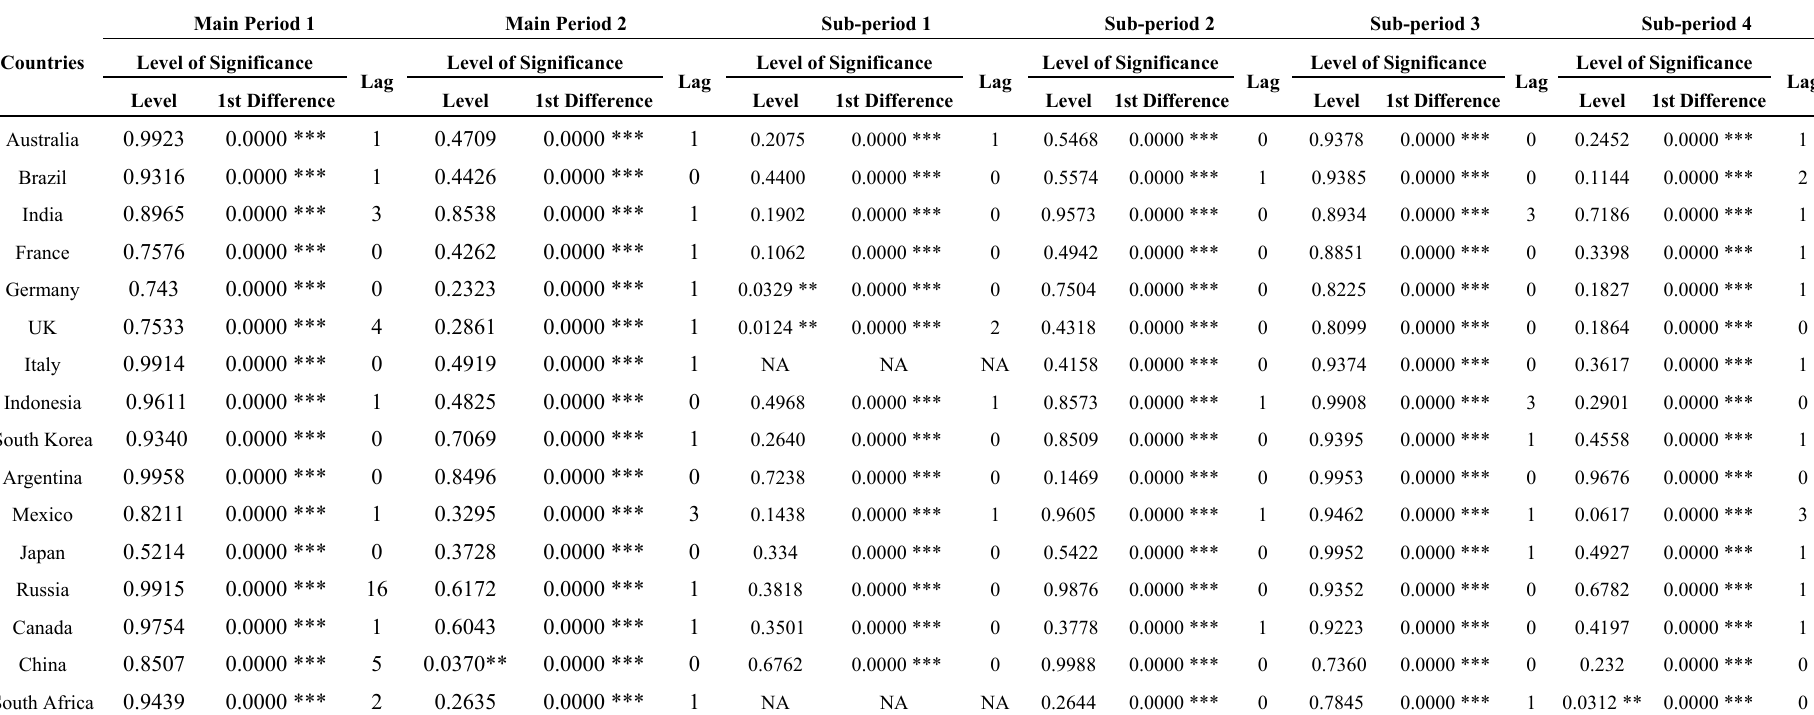
Table 1. Unit Root Test